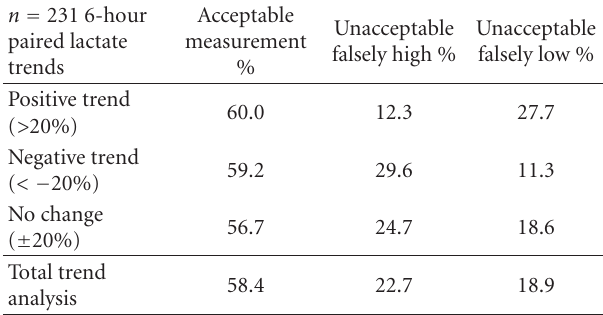
Table 5: Clinical evaluation of 6-hour lactate trend analysis from subcutaneous adipose tissue ( Δ sat LAC) versus arterial blood ( Δ art LAC) after 6-hour 1-point calibration. Lactate measurements are stratified to positive, stable and negative lactate